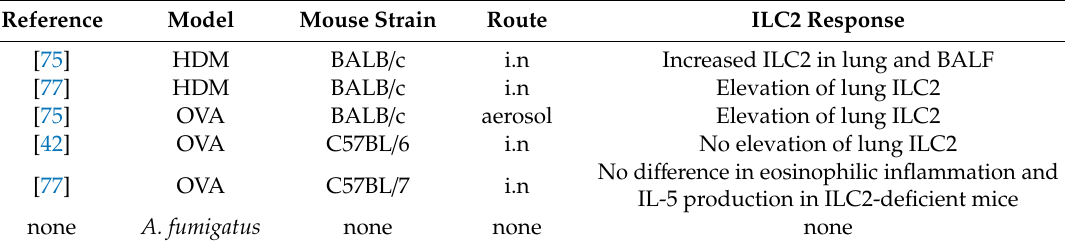
Table 2. Summary of ILC2 response of each murine asthma